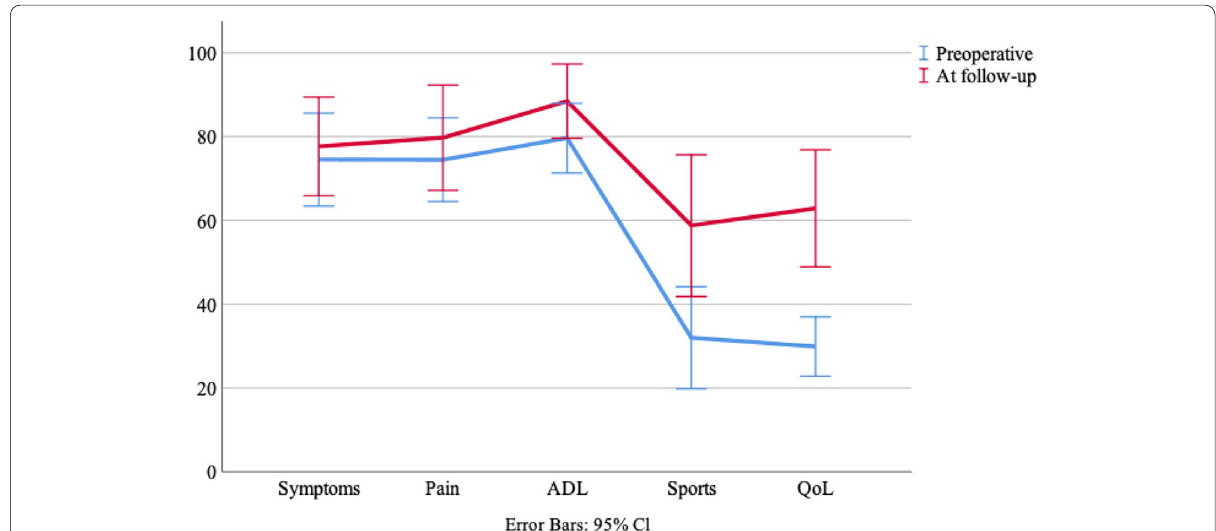
Fig. 4 Preoperative and follow-up Knee injury and Osteoarthritis Outcome Score (KOOS) (mean (95%